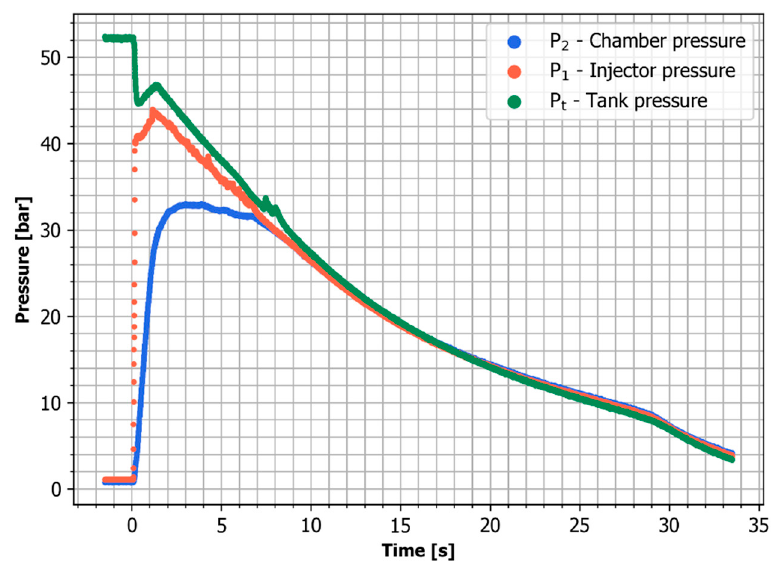
Figure 4. Pressure time history of a typical test. The valve opens at approximately 0 s. Data for the Injector No. 2.